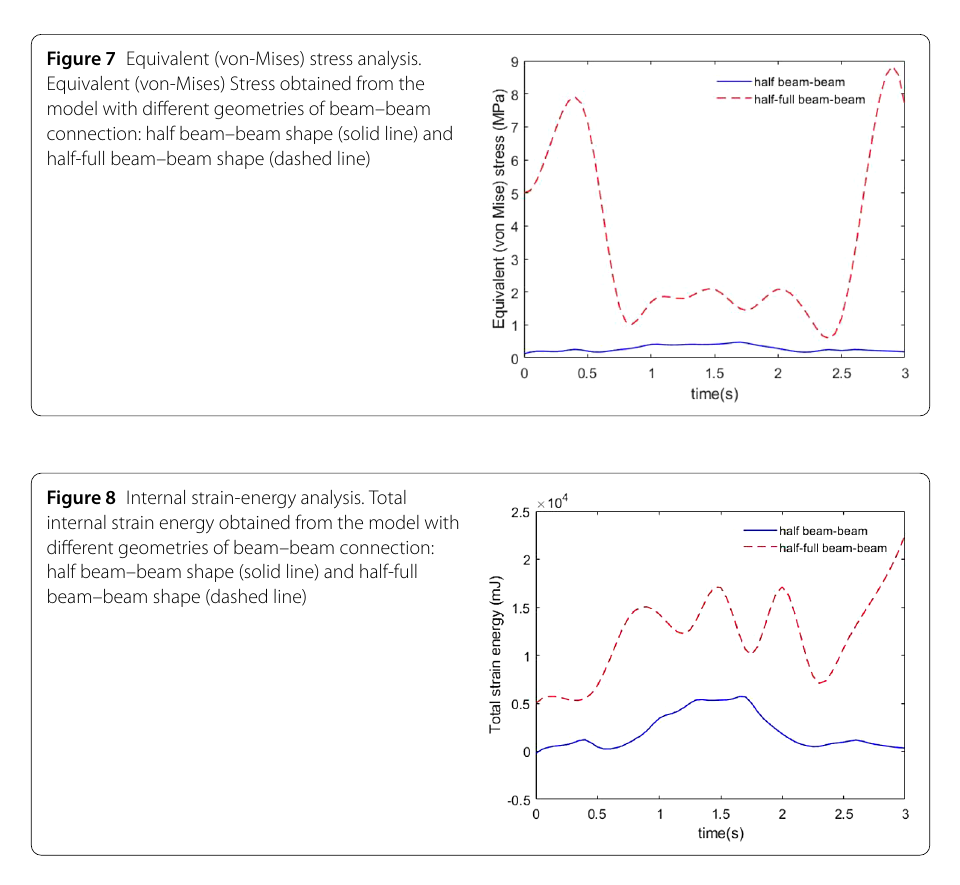
Figure 7 Equivalent (von-Mises) stress analysis. Equivalent (von-Mises) Stress obtained from the model with different geometries of beam–beam connection: half beam–beam shape (solid line) and half-full beam–beam shape (dashed line)